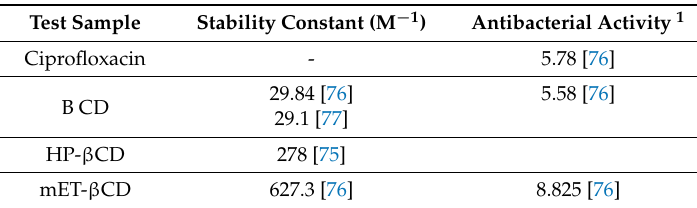
Table 2. Stability constants of ciprofloxacin with β CD derivatives and antibacterial activity of ciprofloxacin/ β CD derivative complexes against MRSA.